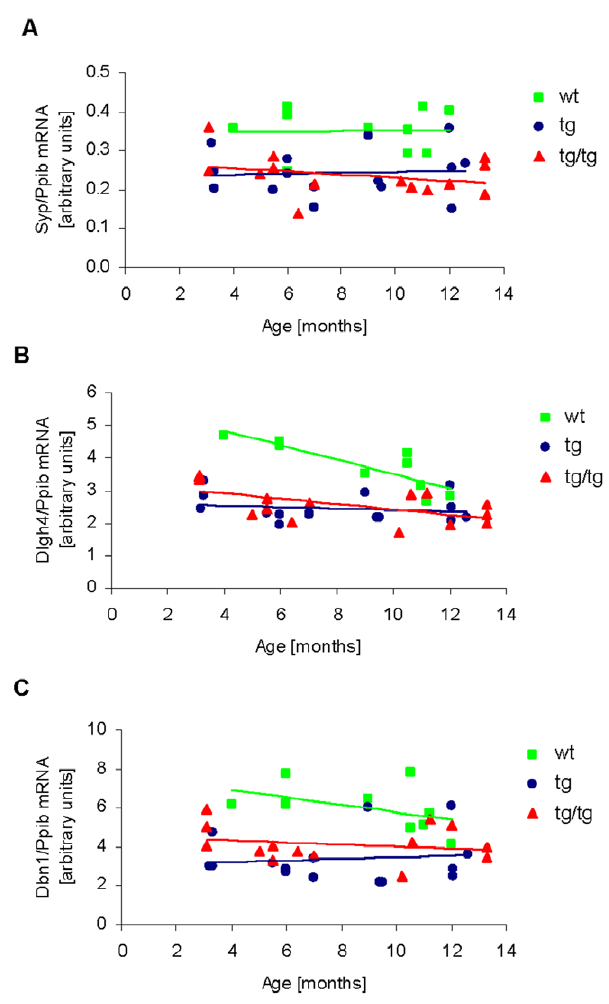
Figure 5. mRNA expression analysis of synaptic marker proteins in the brain of ARTE10 mice. A , Synaptophysin (Syp), B , Disk large homolog 4 (Dlgh4), and C , Drebrin (Dbn1) mRNA expression in hemizygous and homozygous ART10 mice were analyzed in comparison to wild type animals. Material from comparable brain regions of mice ranging from 3 to 13 months of age was used for each of these studies. mRNA has been extracted from the brain material and expression of Synaptophysin, Disk large homolog 4, and Drebrin was measured applying real-time quantitative PCR. For normalization, each ratio of Synaptophysin, Disk large homolog 4, and Drebrin values with Cyclophilin B (Ppib) have been calculated and are shown as linear regression lines. In comparison to wild type mice hemi- as well as homozygous mice revealed a significant lower mRNA level of Synapto- physin(p=0.0011;0.0003), Disk large homolog 4 (p=0.0003;0.0011), and Drebrin (p=0.0003; 0.0002) respectively (see also Fig. S9); statistical analyses were done by Mann-Whitney test. Additionally, in wild type mice mRNA expression of Dlgh4 and Dbn1 were decreased with aging (p=0.0013; 0.0253); no such decrease with aging was shown for Synaptophysin (p=0.5140). Analysis was done by regression diagnostic.